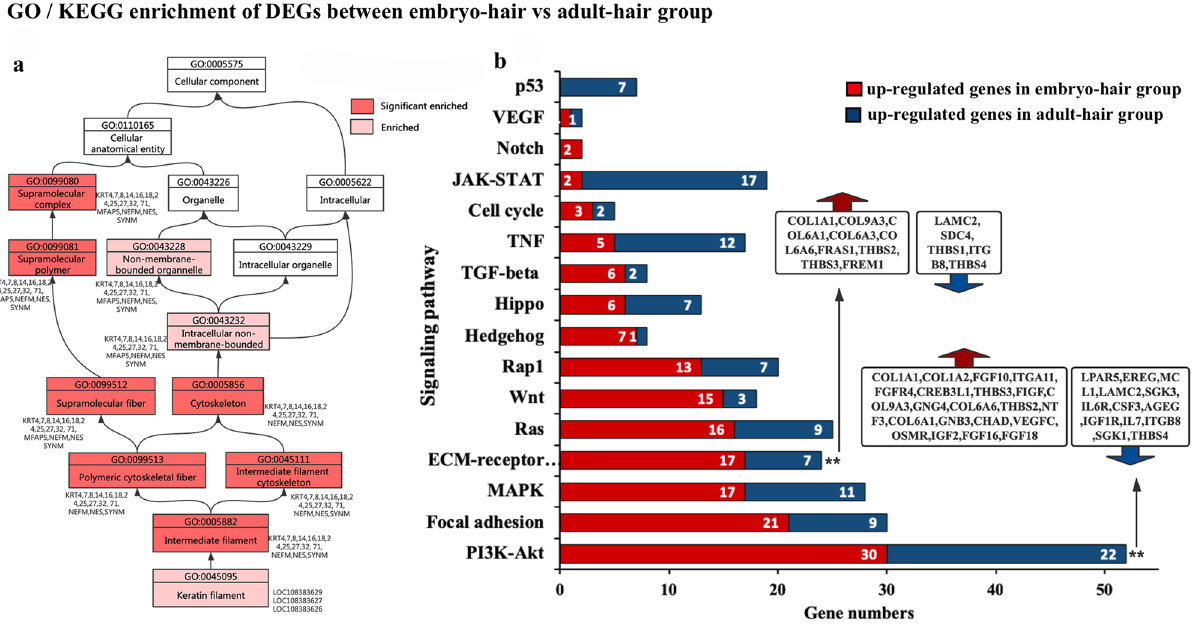
Figure 2. GO and KEGG enrichment analysis of DEGs between embryo-hair vs adult-hair group. ( a ) Directed acyclic graph (DAG) associated with keratin filament term based on GO enrichment analysis; ( b ) Genes and signalling pathways related to hair